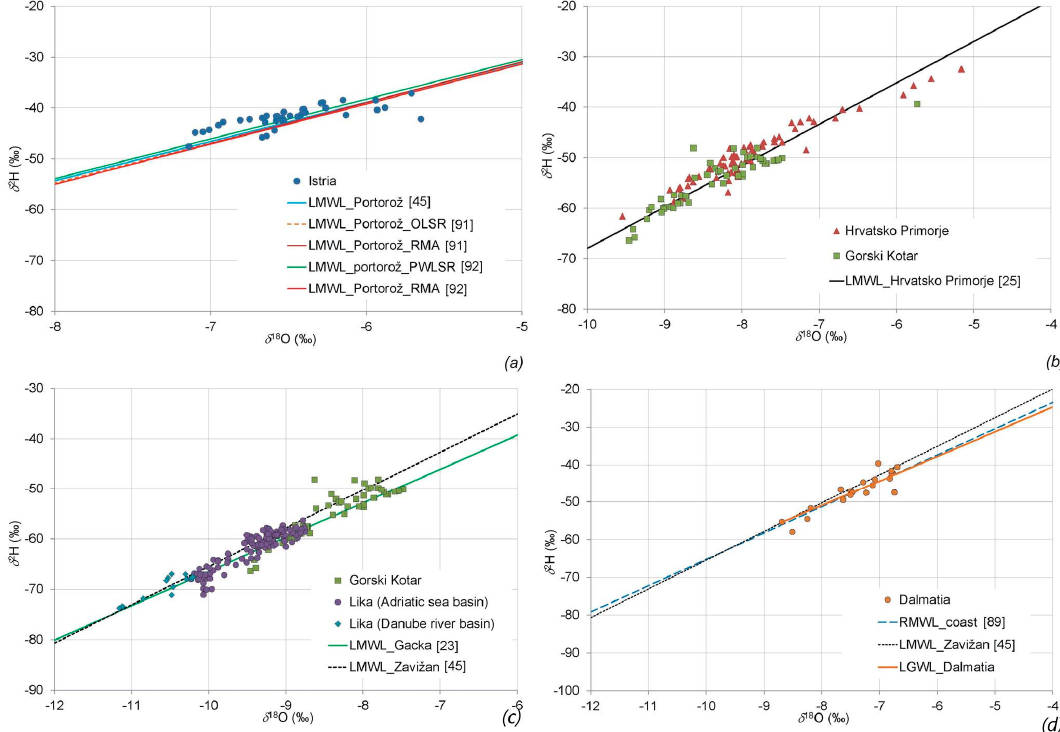
Figure 3. Local meteoric water lines (LMWLs) and the single values of the groundwater stable isotopes in the Dinaric karst in Croatia: ( a ) Istria, ( b ) Hrvatsko Primorje and Gorski Kotar, ( c ) Gorski Kotar and Lika, and ( d ) Dalmatia. 300